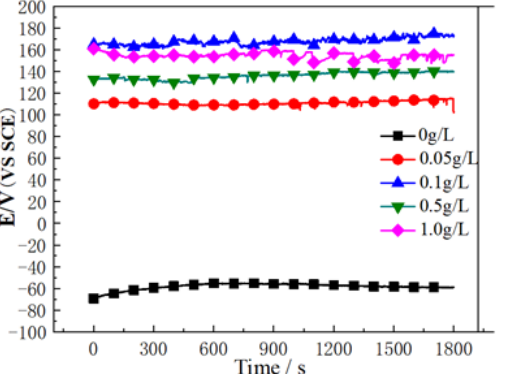
Figure 12. Open circuit potential of TP2 copper in acetic acid solution containing BTA.